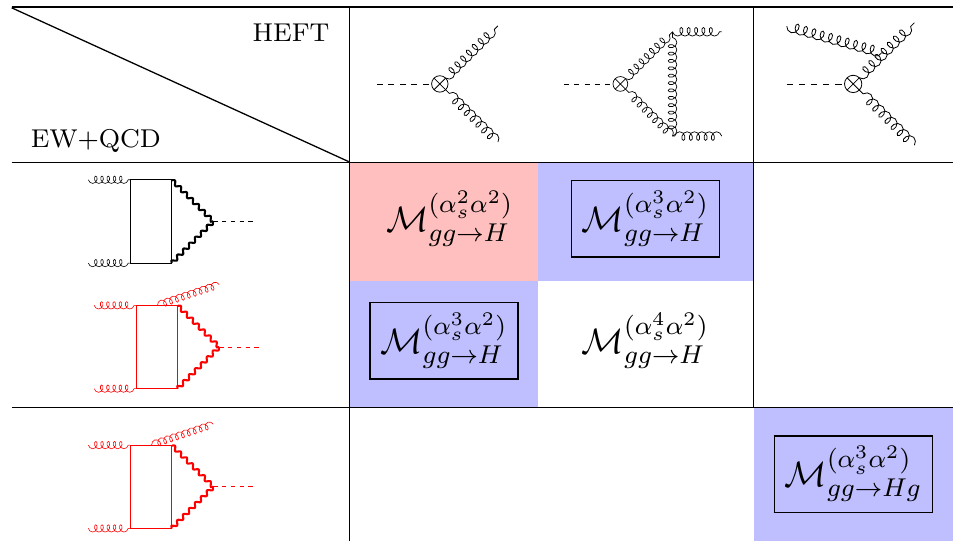
Table 1 . Overview of the relevant interferences necessary for the computation of the cross sections 2 2 + α 3 2 ) σ ( α s α s α gg → H +